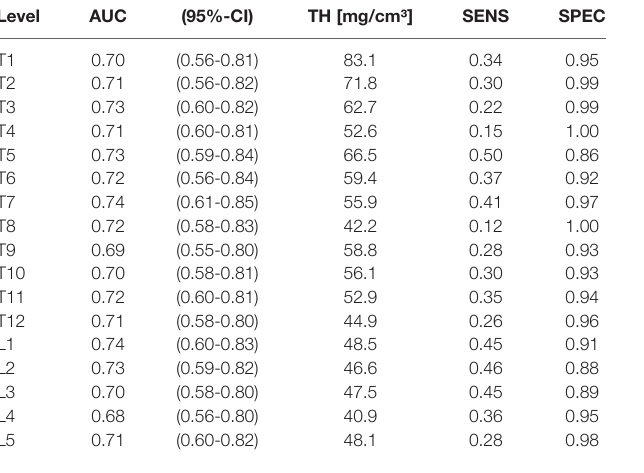
TABLE 4 | Single vertebra analysis: AUC (with 95%-CI), vBMD threshold yielding highest accuracy (TH; mg/cm³), and corresponding sensitivity (SENS) and speci fi city (SPEC). TABLE 5 | Average across four consecutive vertebrae and L1-L2: AUC (with